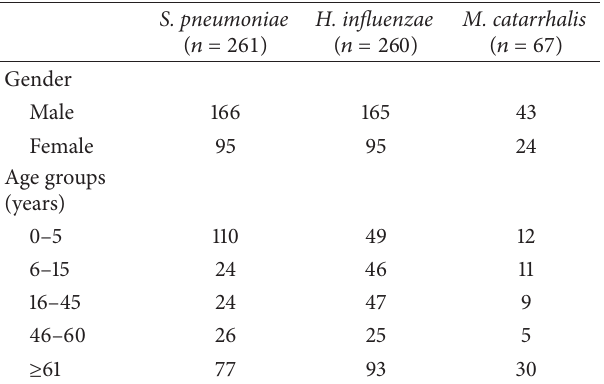
Table 2: Numbers of isolates of H. influenzae , S. pneumoniae , and M. catarrhalis , grouped according to gender and